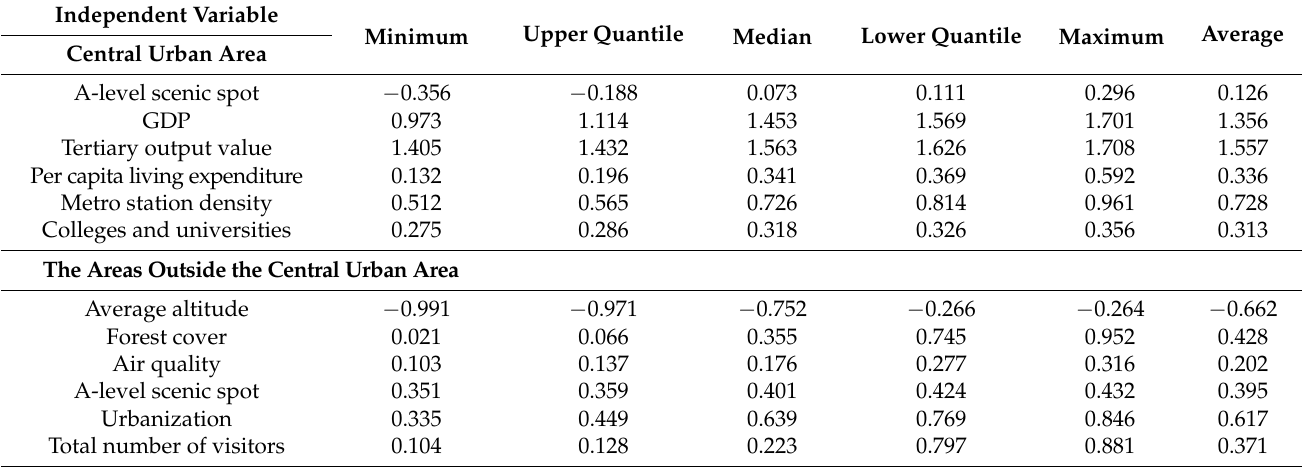
Table 5. Statistical results of the GWR model coefficient